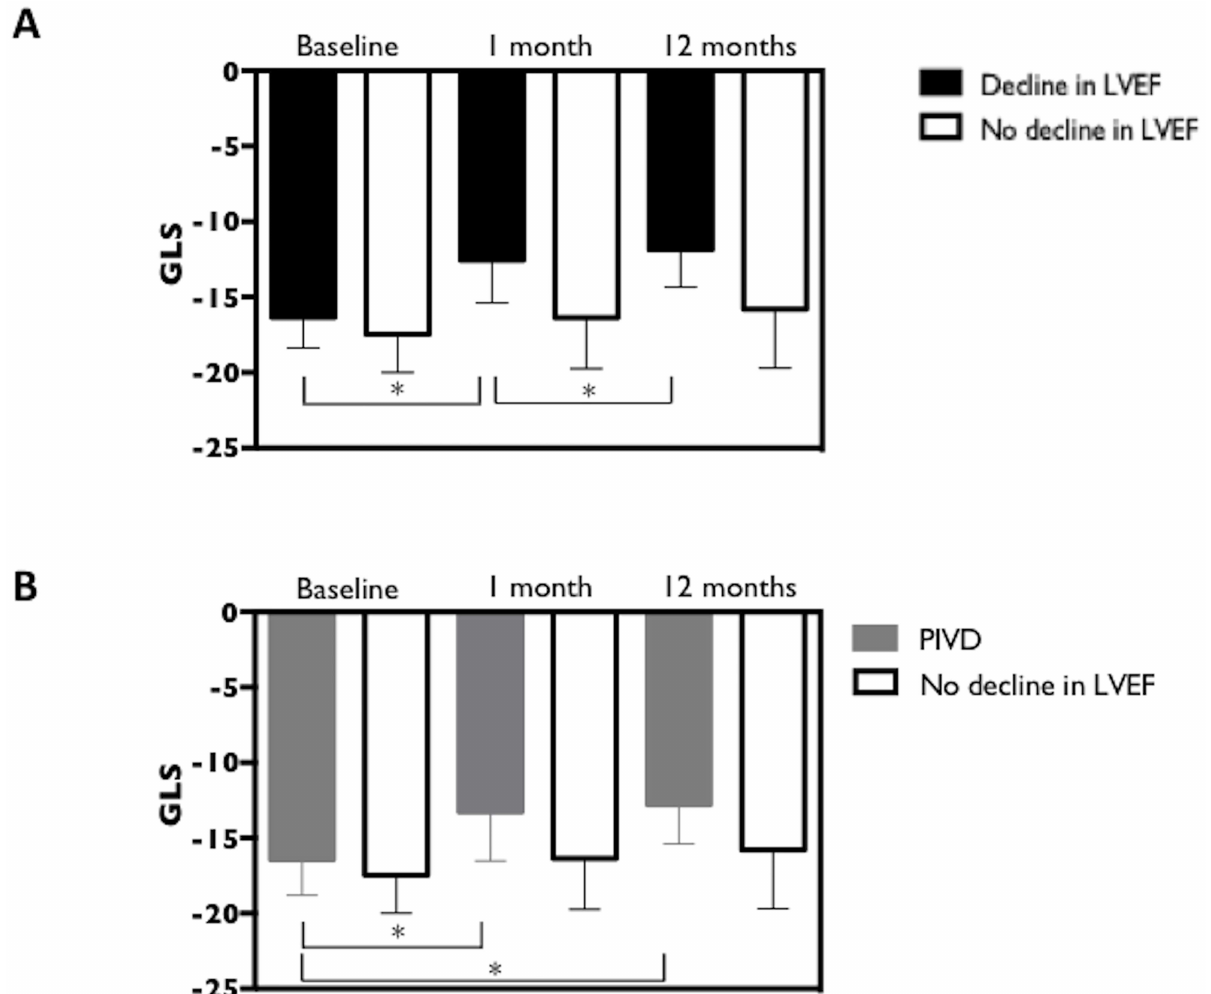
Fig 3. (A) Global longitudinalstrain for cases of all cases of PIVD (PICMP included). Global longitudinal strain was significantly lower in patients with a declinein LVEF (cid:21) 5% comparedto cases without (one month GLS -12.6 ± 0.9 vs. -16.4 ± 0.6 respectively; p = 0.022). One and 12 month GLS were reducedcomparedto baselinefor cases of with a declinein LVEF at 12 months (PIVD and PICMP), but not for cases without a declinein LVEF (PIVD and PICMP: baselineGLS, -16.3 ± 0.5 vs. -12.6 ± 0.9 and -11.9 ± 2.5; p = 0.012. No declinein LVEF: baselineGLS -17.5 ± 0.6 vs. -16.4 ± 0.6 and -15.8 ± 3.9; p = 0.311). (B) Global longitudinal strain for cases with PIVD (PICMP excluded). One and 12 month GLS were significantly reducedfor cases of PIVD comparedto baseline(BaselineGLS -16.4 ± 0.7 vs -13.3 ± .2 and -12.8 ± 2.6 respectively;p =